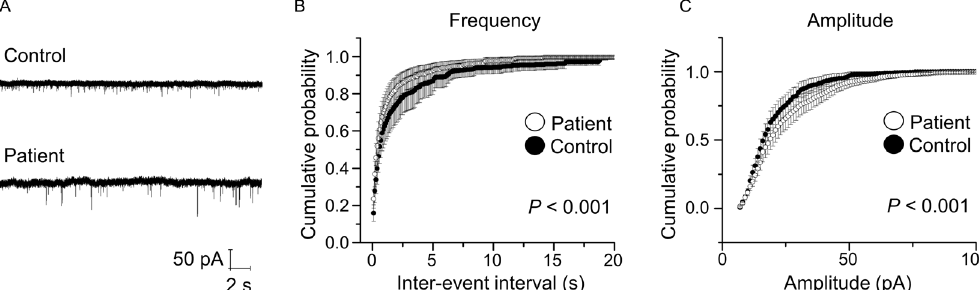
Fig. 2 Increased frequency and amplitude of mEPSCs in iPSC-derived neurons from patients. A Representative traces of mEPSCs obtained from iPSC-derived neurons from controls and patients. B Cumulative probability plot showing a signi fi cant shift of the distribution of inter- event interval toward shorter intervals in iPSC-derived neurons from patients. C Cumulative probability plot showing a signi fi cant shift of the distribution of amplitude toward a larger amplitude in iPSC-derived neurons from patients. P < 0.001, Kormogorov – Smirnov test. Data were presented as mean ± standard error of the mean (SEM).